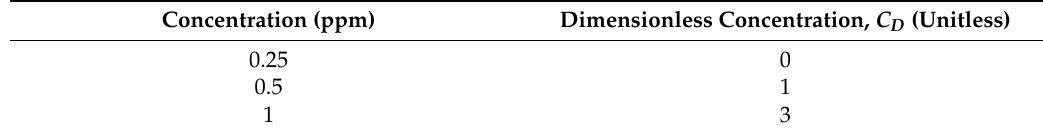
Table 2. AOS Concentrations and their respective dimensionless concentration.